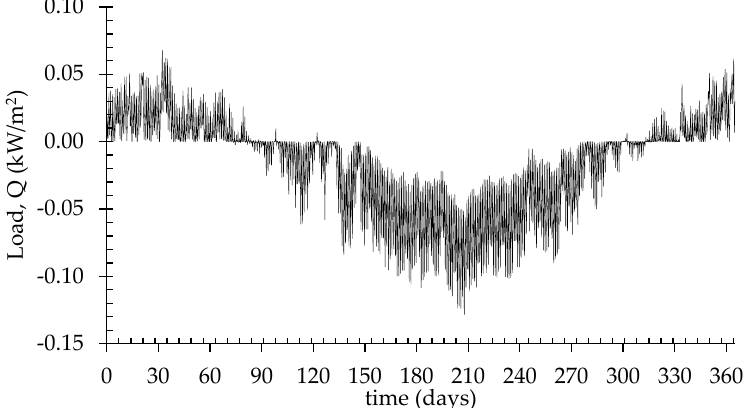
Figure 4. Heating (positive values) and cooling (negative values) load, Q, of the investigated residential building for a year. Table 1. Heating and Cooling loads per month.